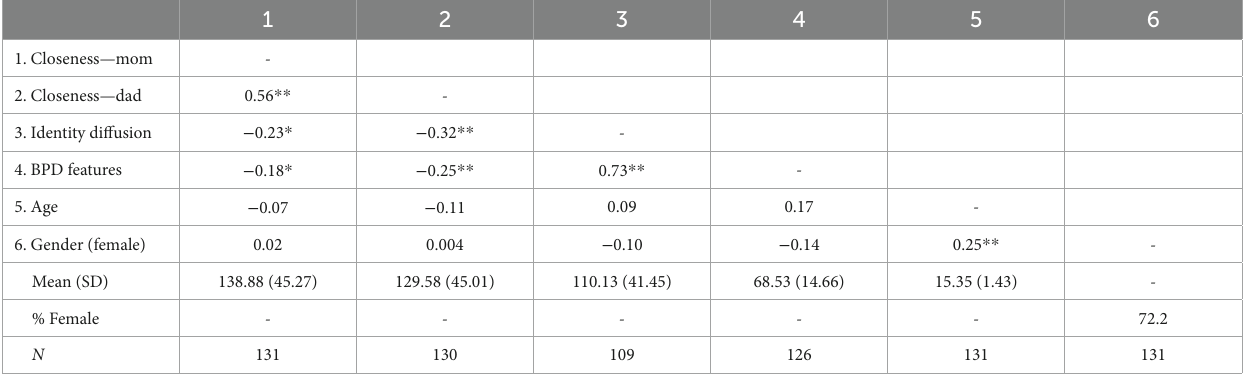
TABLE 1 Bivariate correlations between main study variables.